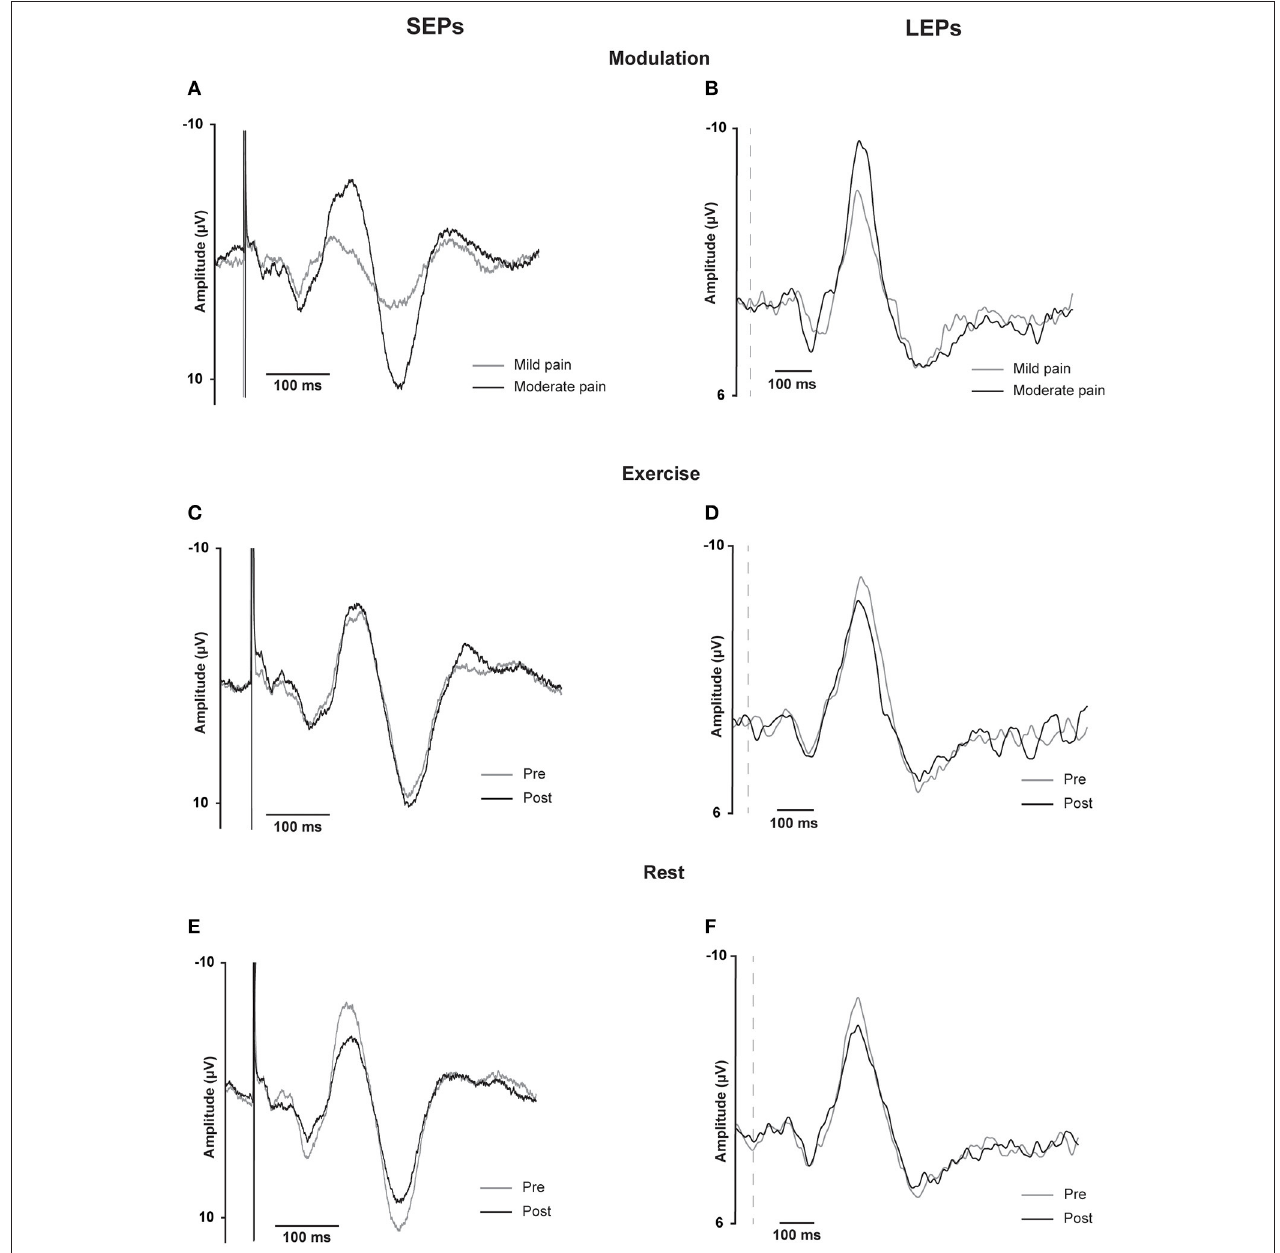
FIGURE 3 | SEP and LEP grand averages for Cz. Somatosensensory evoked potentials recorded at Cz from 16 participants in Experiment 1 (SEPs, A,C,E on the left) and laser evoked potentials recorded at Cz from 16 participants in Experiment 2 ( B,D,F on the right). These traces are the grand averages across participants of individual waveform averages from approximately 500 stimuli for the SEPs and from approximately 30 stimuli for the LEPs. Data are shown for SEPs and LEPs recorded during the modulation test in response to different intensities of stimulation (A,B) or immediately before and after exercise (C,D) or rest (E,F) . For the modulation test, two stimulus intensities corresponding to either mild or moderate pain were randomly presented within the same sequence of 5 test blocks. For the SEPs, data are shown for 50 ms before and 450 ms following the stimulus onset; the stimulus artifact is visible on each plot and has been truncated for the illustration. For the LEPs, data are shown for 50 ms before and 950 ms following the stimulus onset; the vertical dashed lines represent stimulus